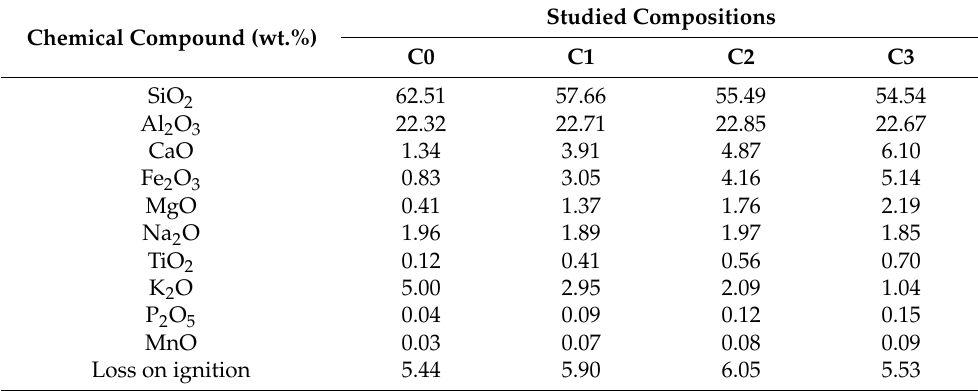
Table 3. Chemical composition by XRF of studied compositions.